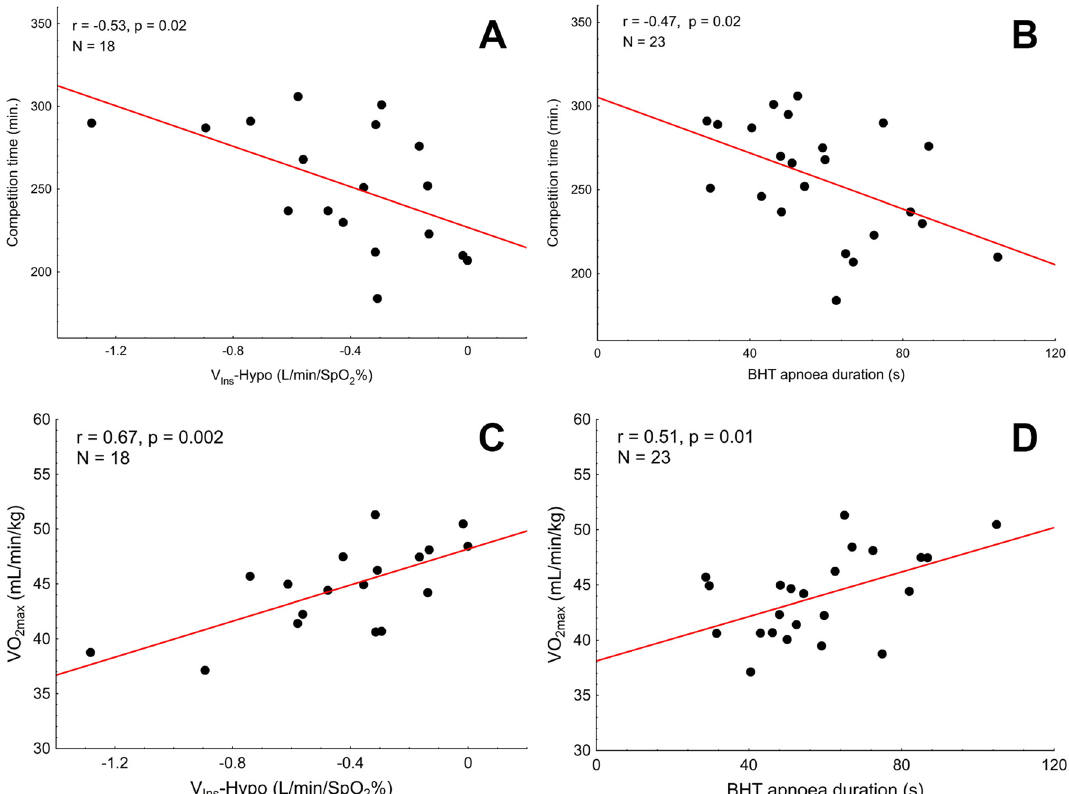
Figure 4. Correlations between the ventilatory response to the chemoreceptor-stimulating manoeuvres (transient hypoxia and breath-holding) and the parameters of individual performance: the marathon time and VO 2max . ( A ) The competition time plotted against V Ins -Hypo (minute ventilation-response to the transient hypoxia). ( B ) The competition time plotted against the pre-race BHT apnoea duration. ( C ) VO 2max plotted against V Ins -Hypo (minute ventilation-response to the transient hypoxia). ( D ) VO 2max plotted against the pre- race BHT apnoea duration.